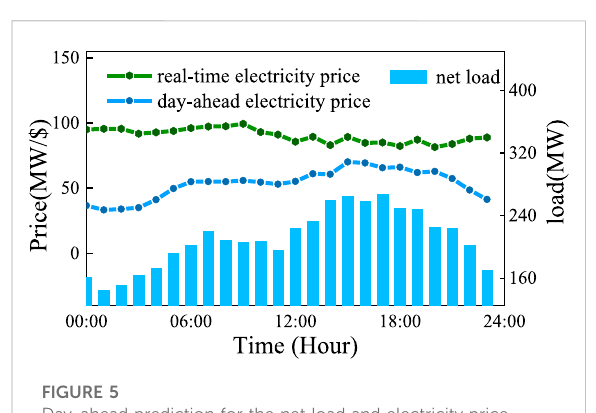
FIGURE 5 Day-ahead prediction for the net load and electricity price.